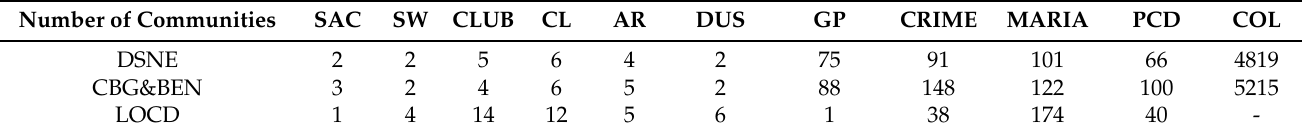
Table 5. Number of communities obtained by the three algorithms in the eleven datasets. Number of Communities